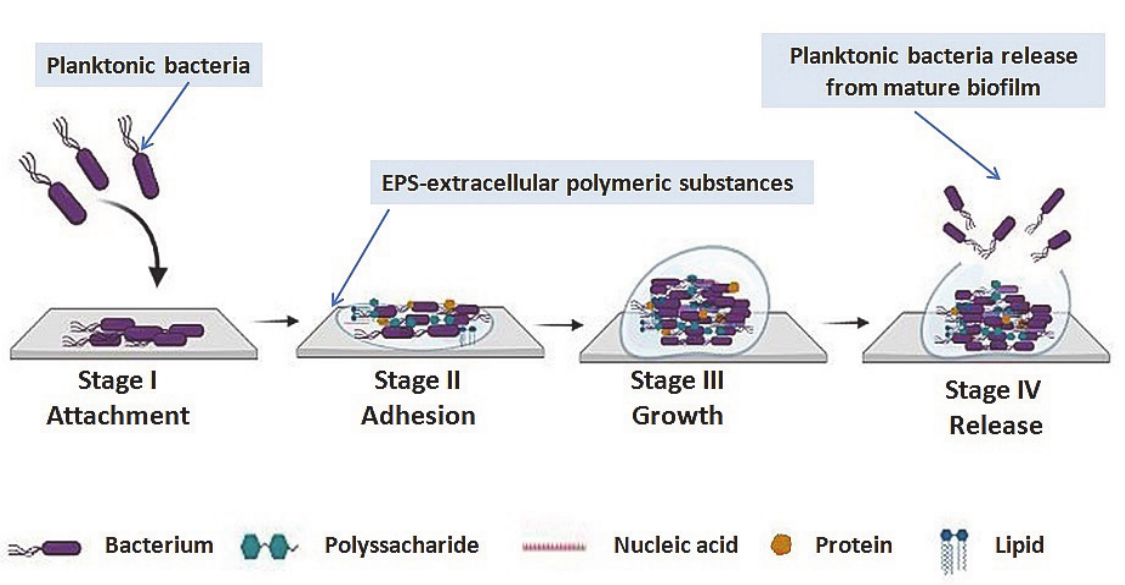
Figure 1. The stages of biofilm formation (created with BioRender.com (accessed on 1 September